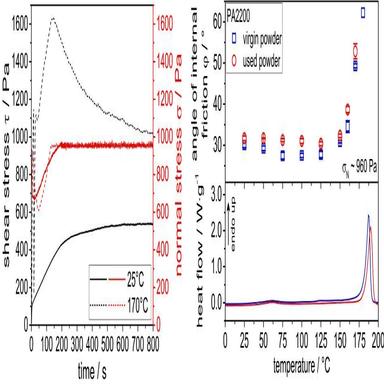
(Left) Shear progression over time for virgin PA12 at 25 ◦C and 170 ◦C. (Right) Angle of internal friction and thermograms for virgin and three times recycled PA12 powder at elevated temperatures. Error bars indicate the standard deviation over five measurements.